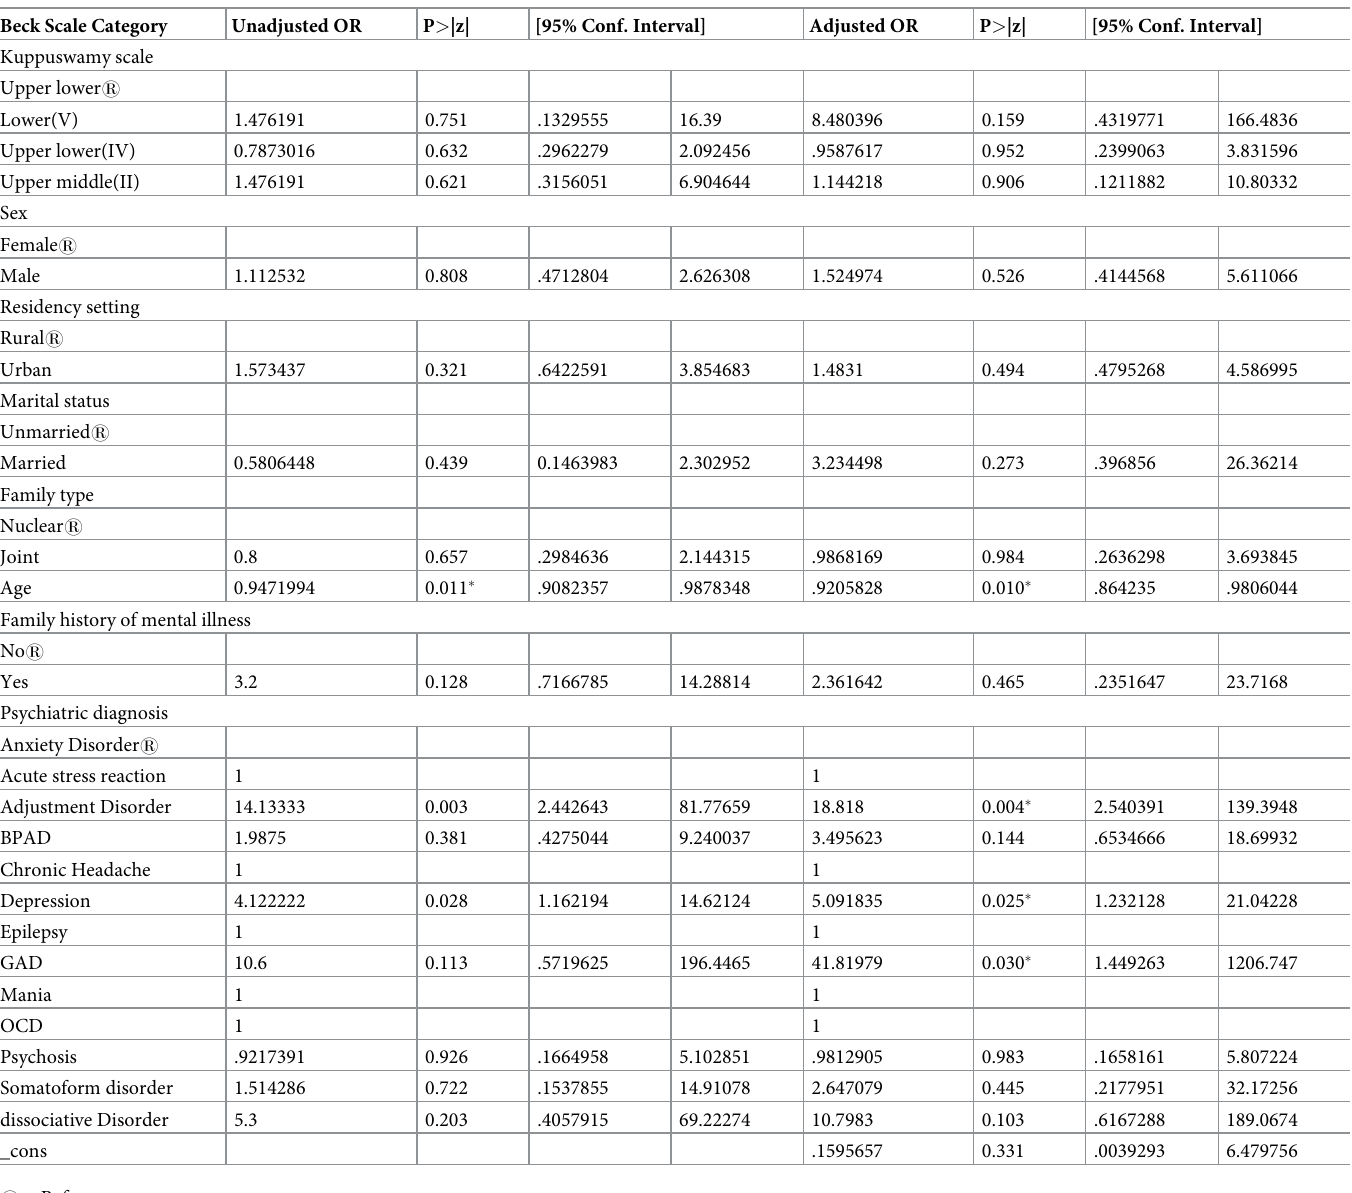
Table 4. Logistic regression analysis to check relation of Beck score category and other independent